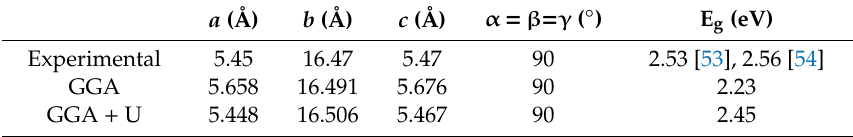
Table 1. Comparison of calculated lattice vectors ( a , b , and c ), angles ( α , β , and γ ), and band gap. a (Å) b (Å) c (Å) α = β = γ ( ◦ ) E g (eV) Experimental 5.45 16.47 5.47 2.53 [53], 2.56 [54] GGA